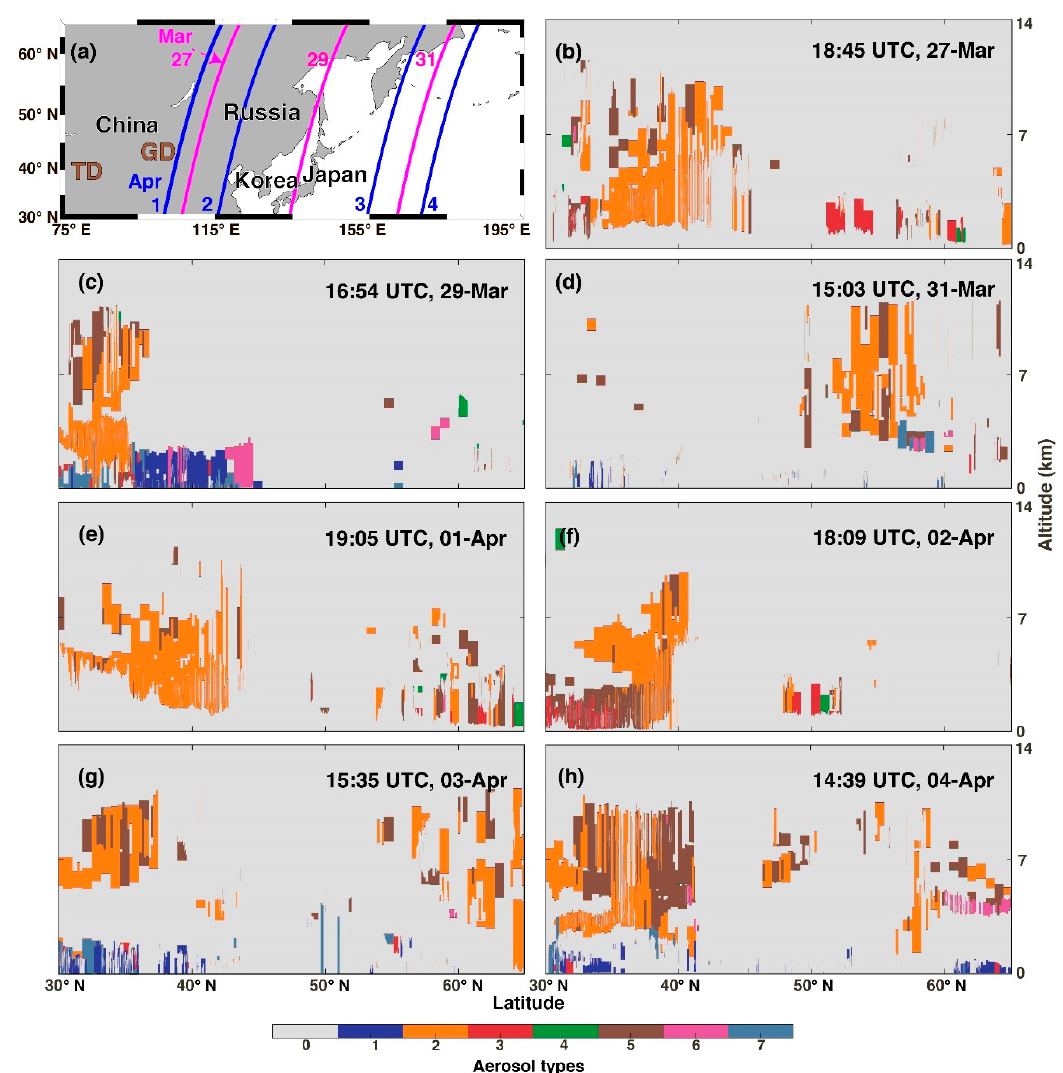
Figure 5. ( a ) CALIPSO satellite orbit paths (pink lines on March and blue lines on April); ( b – h ) Vertical profiles of CALIPSO aerosol types along orbit paths shown in Figure 5a. Color bar indicates aerosol types defined as not determined (0), clean marine (1), mineral dust (2), polluted continental / smoke (3), clean continental (4), polluted dust (5), elevated smoke (6), and dusty marine (7).